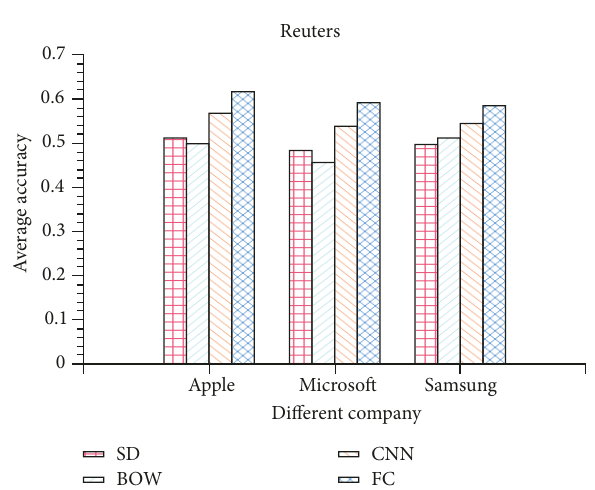
Figure 6: Average accuracy of prediction based on different feature sets for each company in